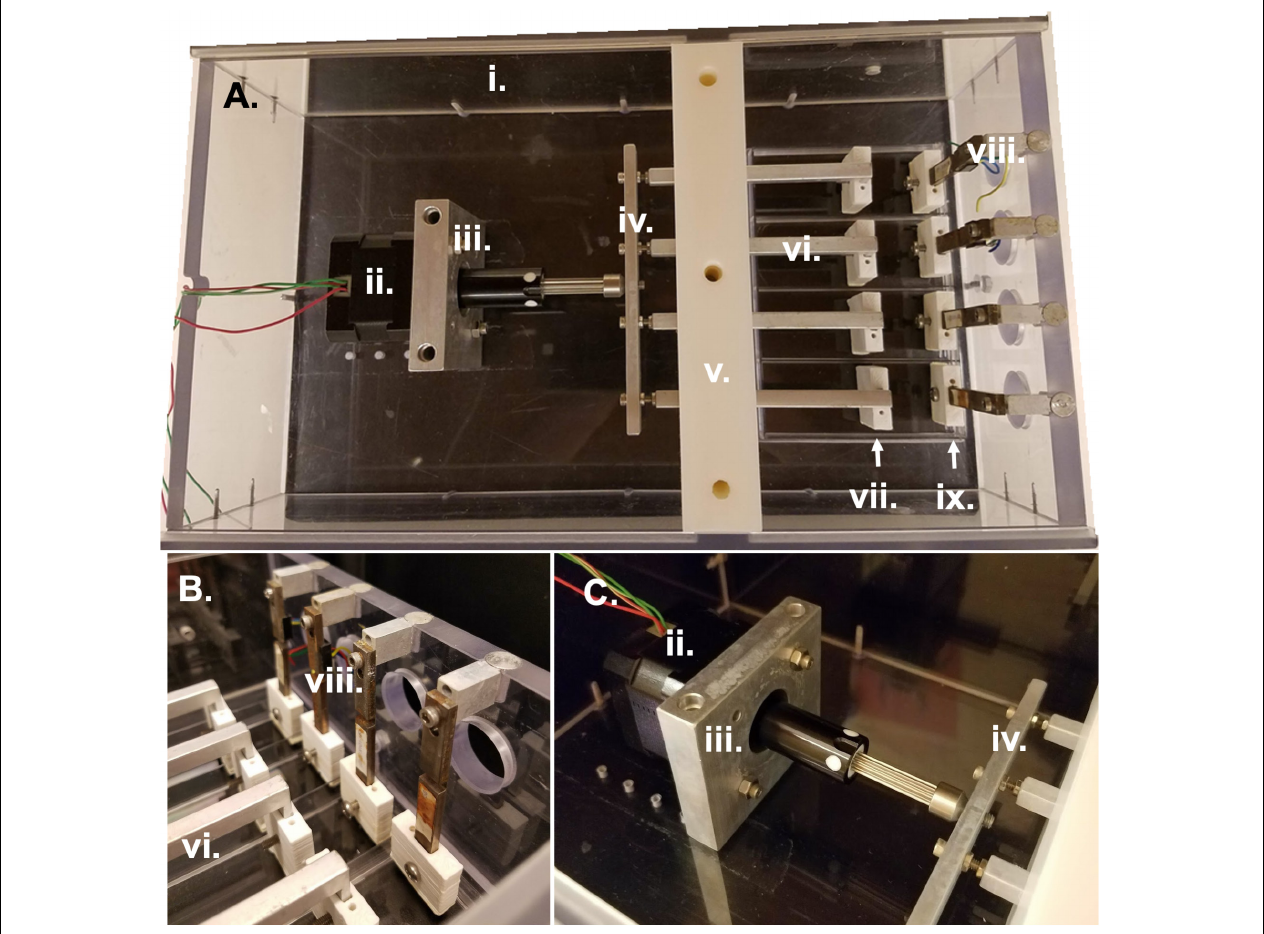
FIGURE 1 | Bioreactor parts and assembly. (A) Overhead view of entire bioreactor system with actuation compartment to the left and sterile culture compartment to the right. (B) Side view of sterile culture compartment displaying the region between force sensors and linear actuators in which samples are clamped. (C) Side view of actuation compartment detailing the motor attachment to the linear actuators and bioreactor housing. All Roman numeral labels refer to the list of materials at the beginning of Materials and